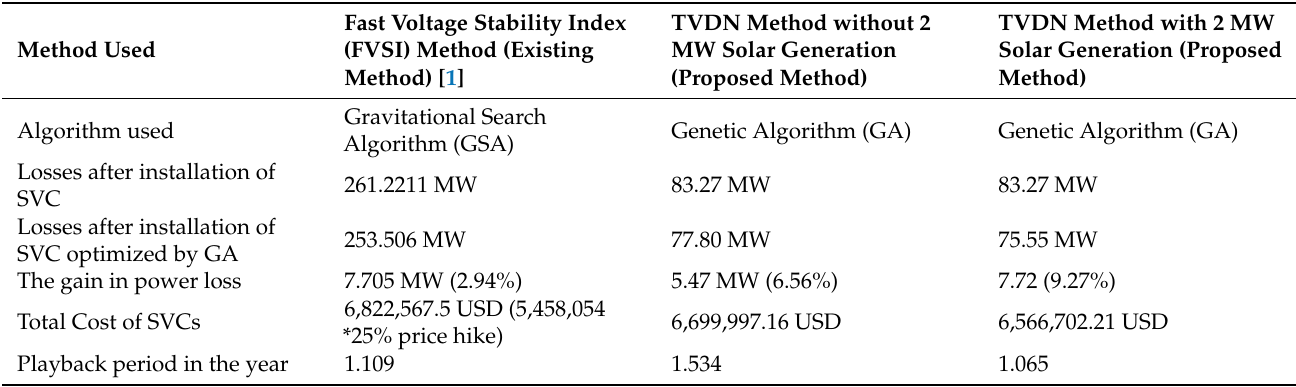
Table 11. Comparative results for the IEEE 14-bus